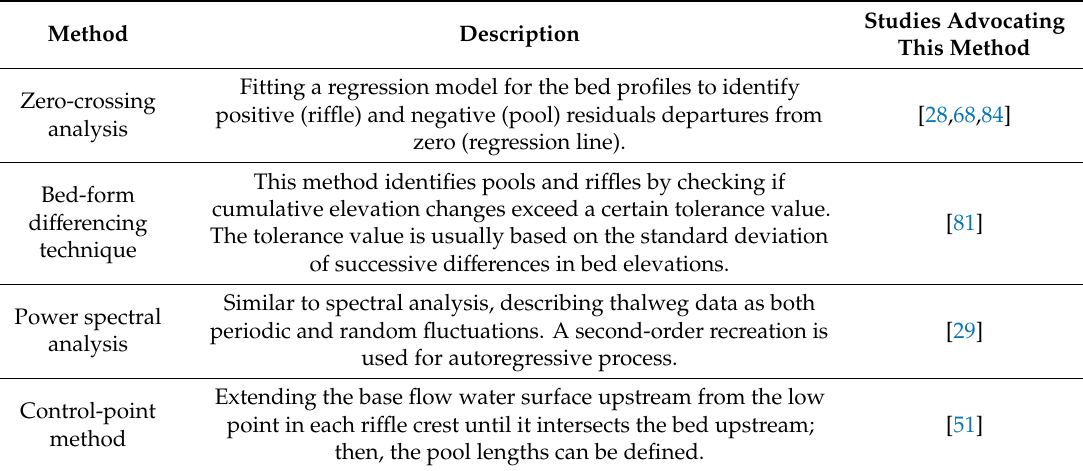
Table 2. Di ff erent methods for analyzing ri ffl e–pool